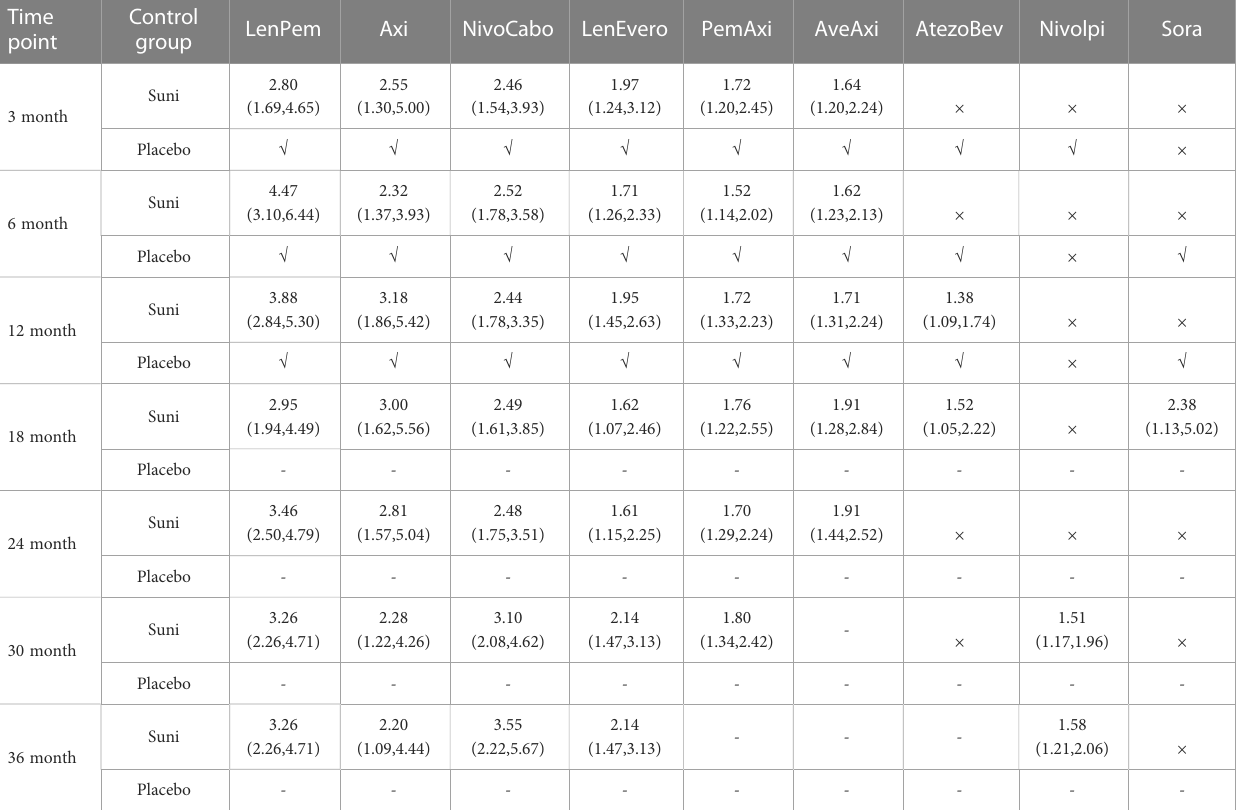
TABLE 2 Progression free survival for each time point for interventions that were signi fi cant compared to Sunitinib (shown as odds ratio and 95% con fi dence intervals).